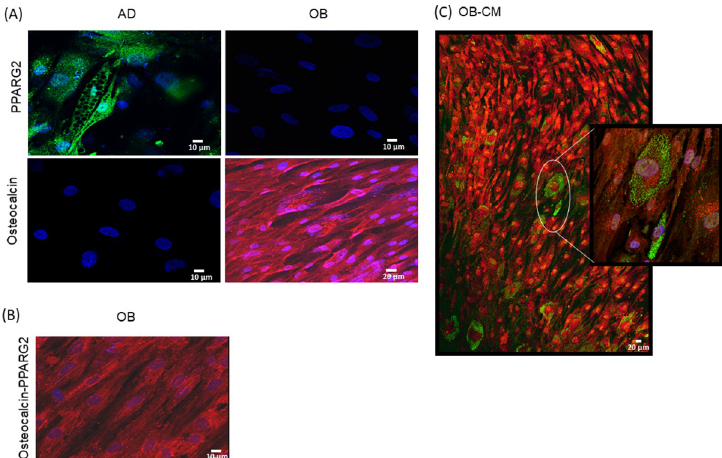
Fig 3. Immunofluorescence microscopic analysis showed the coexpression of adipogenic and osteogenic proteins in OB-CM. (A) Simple immunofluorescence confocal analysis showed that osteocalcin is a specific marker for osteoblasts and PPARG2 is a specific marker for adipocytes. (B) Double immunofluorescence labelling of PPARG2 and osteocalcin in control osteoblasts showed the specificity of osteocalcin staining in OB but not PPARG2. (C) Confocal microscopy analysis of double immunofluorescence labelling of PPARG2 (green) and osteocalcin (red) in osteoblasts incubated with media conditioned by adipocytes at 14 days of differentiation (OB-CM). Blue staining represents DNA (DAPI). The coexpression of the two proteins is clearly visible in the right enlargement. The data shown are representative images of three independent